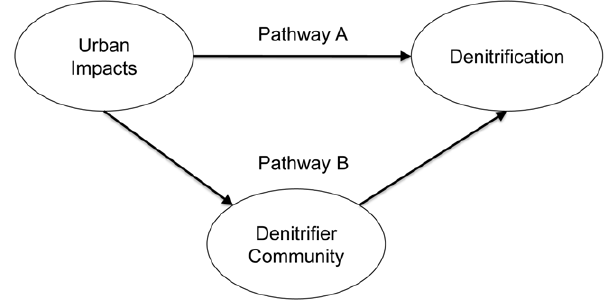
Figure 1. Conceptual diagram describing two causal mecha- nisms through which watershed urbanization might alter denitrification rates in streams. The first mechanism (pathway A) focuses on the direct effect of urbanization on denitrification through changes to nitrate and organic carbon concentrations. The second mechanism (pathway B) focuses on the indirect effect of urbanization on denitrification through changes to denitrifier community composi-